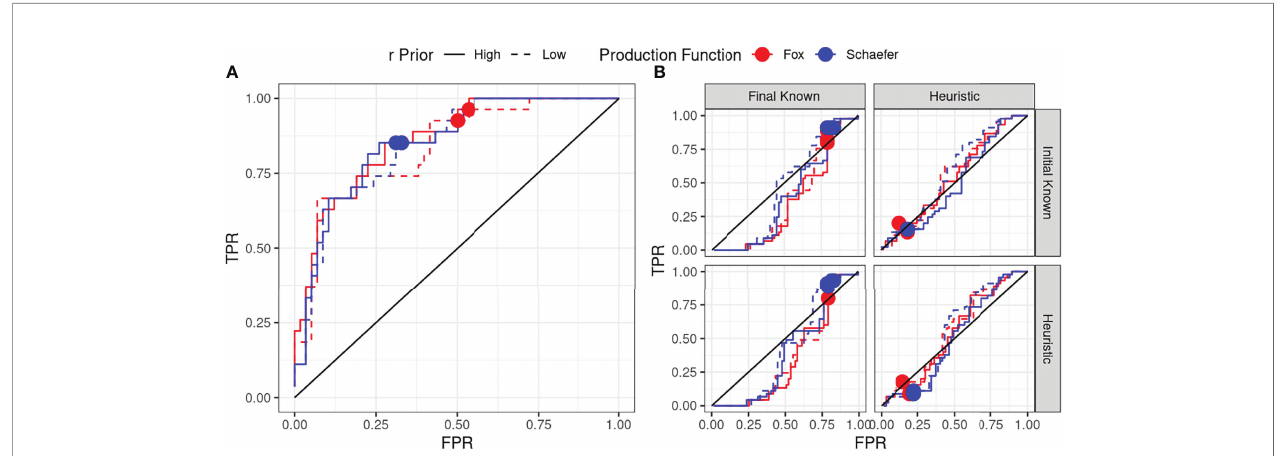
FIGURE 4 | Receiver Operator Characteristics curves for F:F MSY , The biomass dynamic assessment model with the index of abundance estimates are shown in panel (A) , and the catch-only model values in panel (B) The points are for when the estimates of F:F MSY = 1. The black line ( y = x ) is equivalent to a coin toss, and the purple corresponds to the reference case where the heuristic for fi nal depletion alone was used, i.e. running the catch-only model without data. The blue and red lines are the estimatesfor the two production functions, and the dashed/solid lines are for the choice of r prior. The dots correspond to a discrimination threshold of B/B MSY = 1, i.e. is the estimate